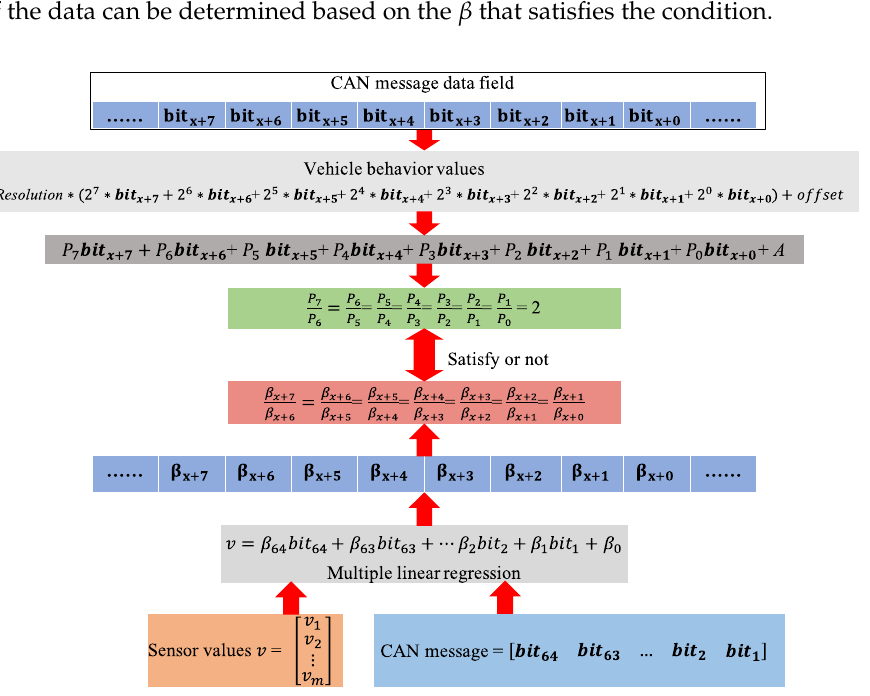
Figure 3. Reverse feasibility based on linear regression.